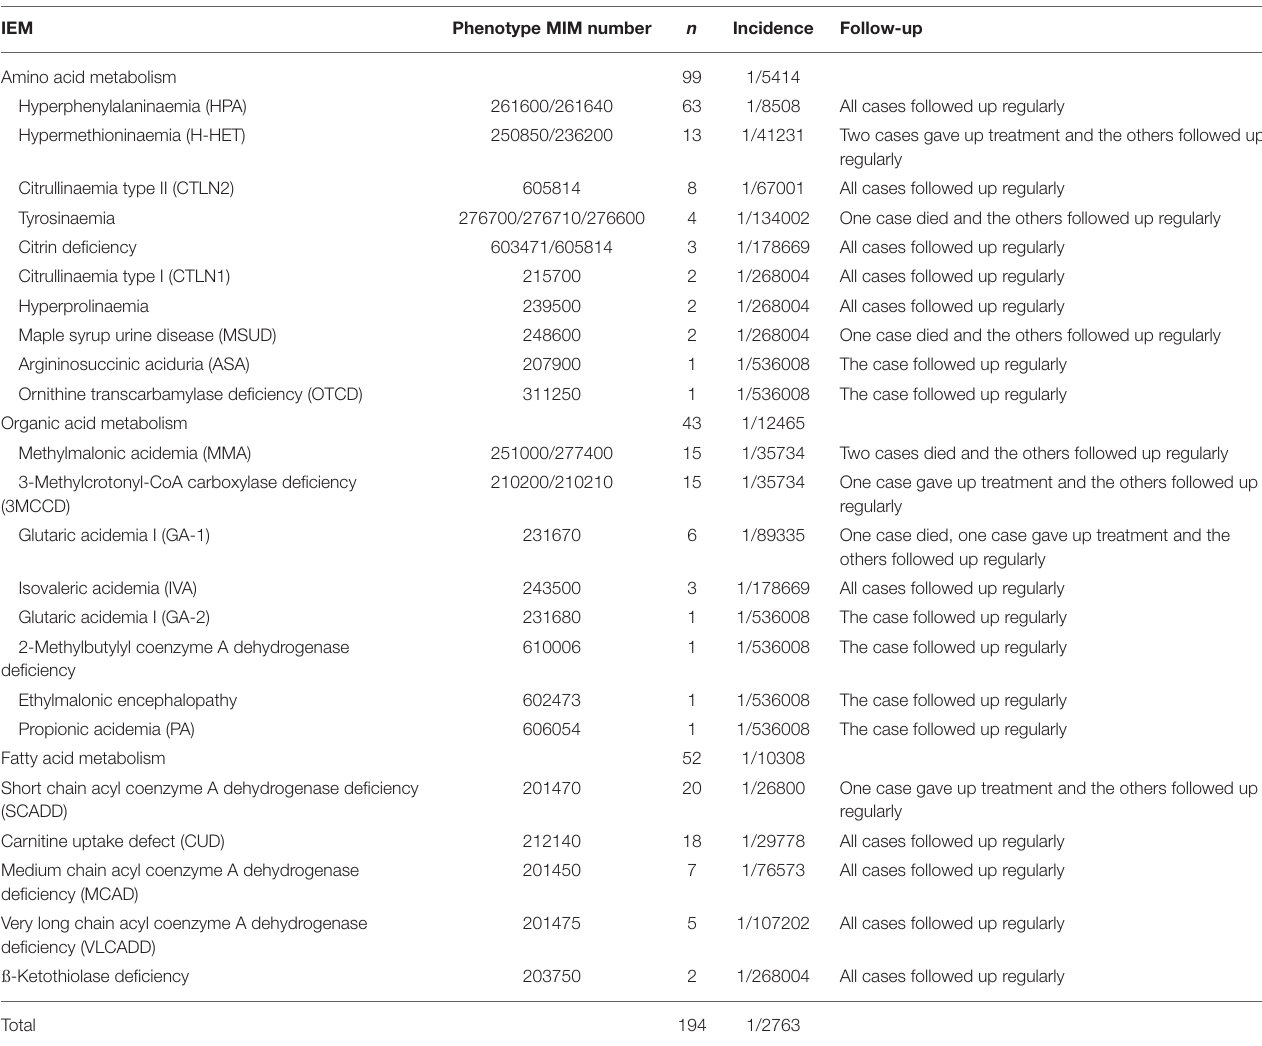
TABLE 3 | Results of 194 infants with